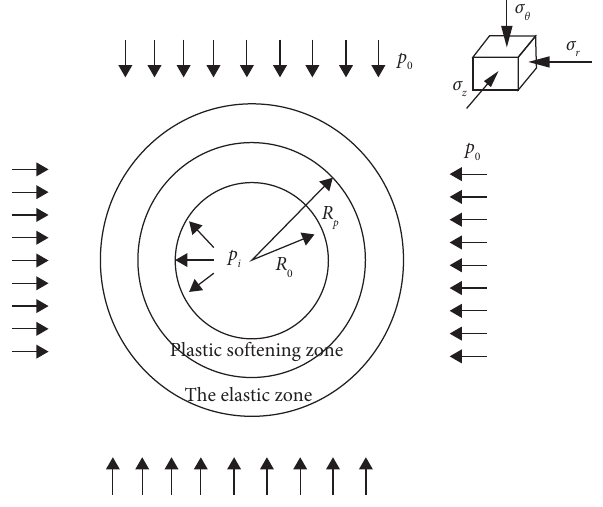
Figure 3: Borehole mechanical